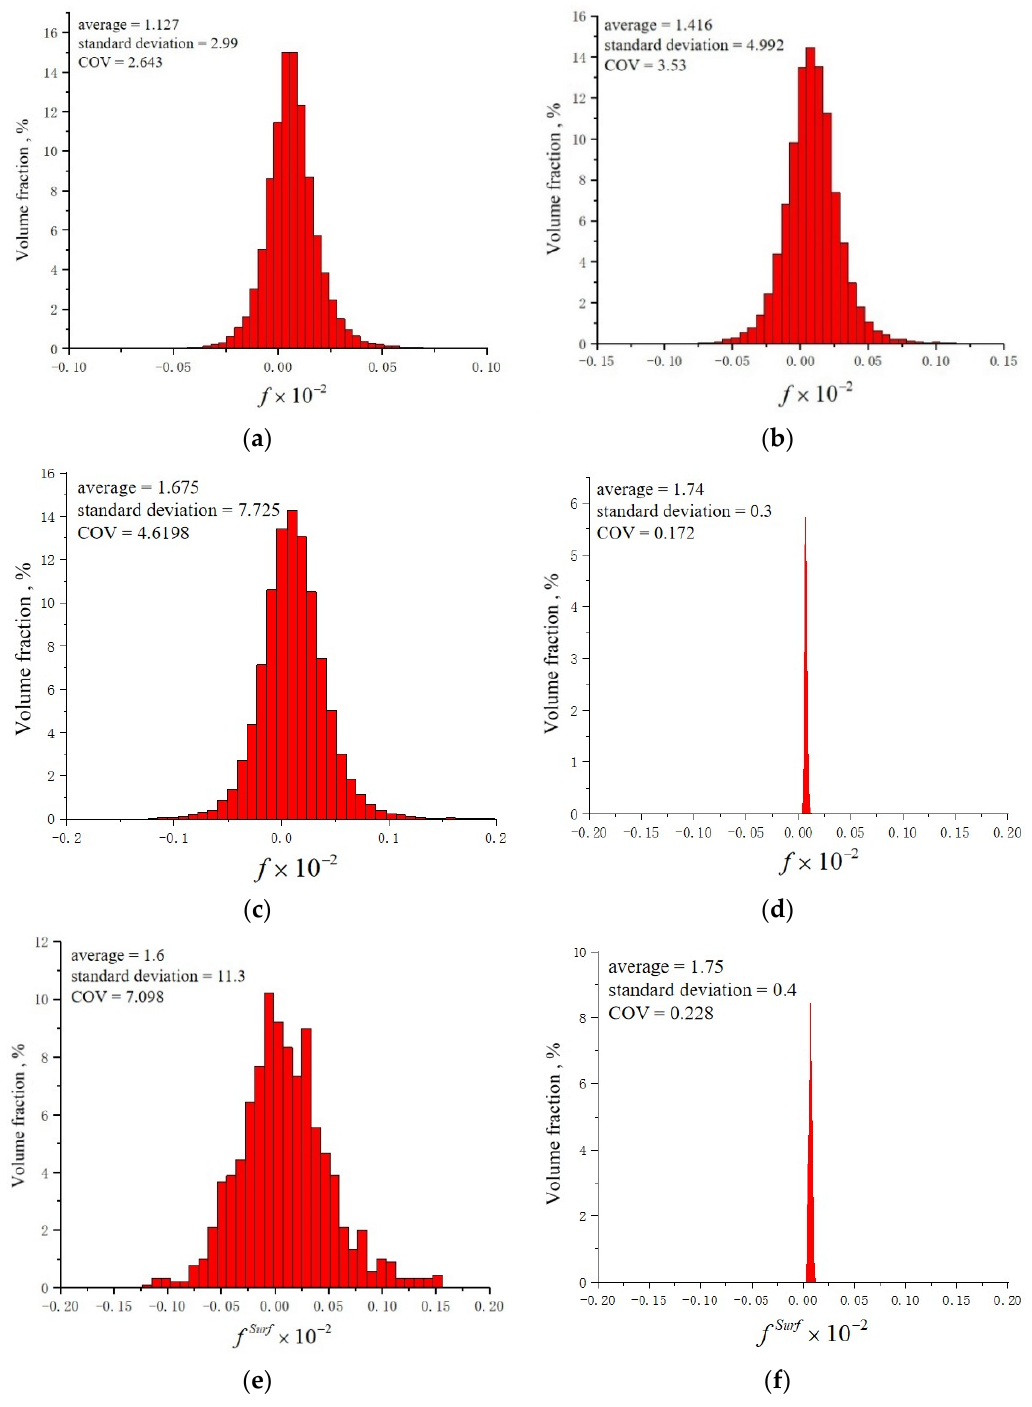
f at the maximum moment of tension f in the Surf f on the free surface in